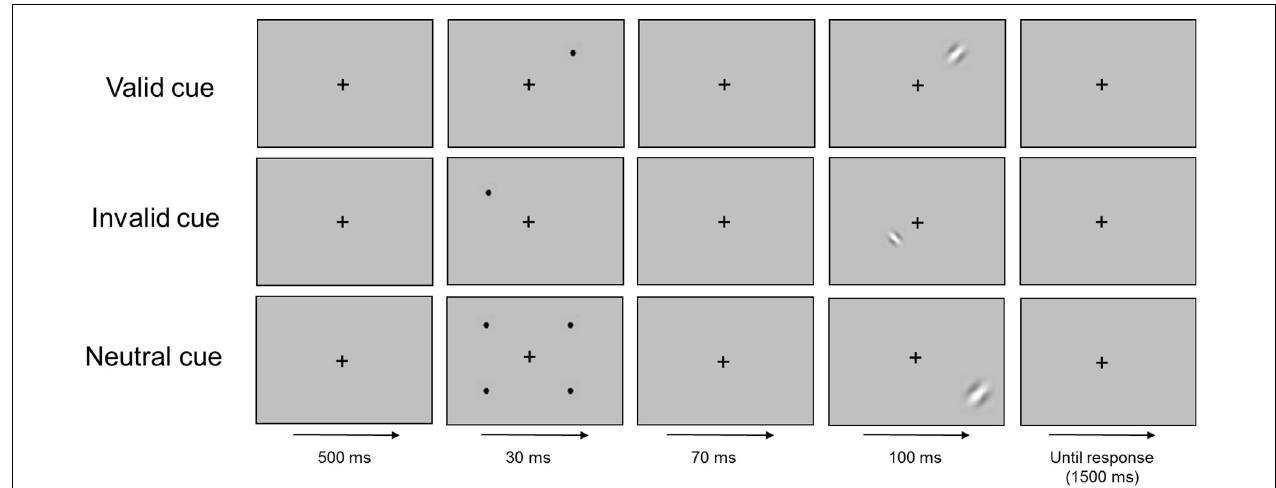
FIGURE 1 | Schematic representation of the time course (left to right) of the